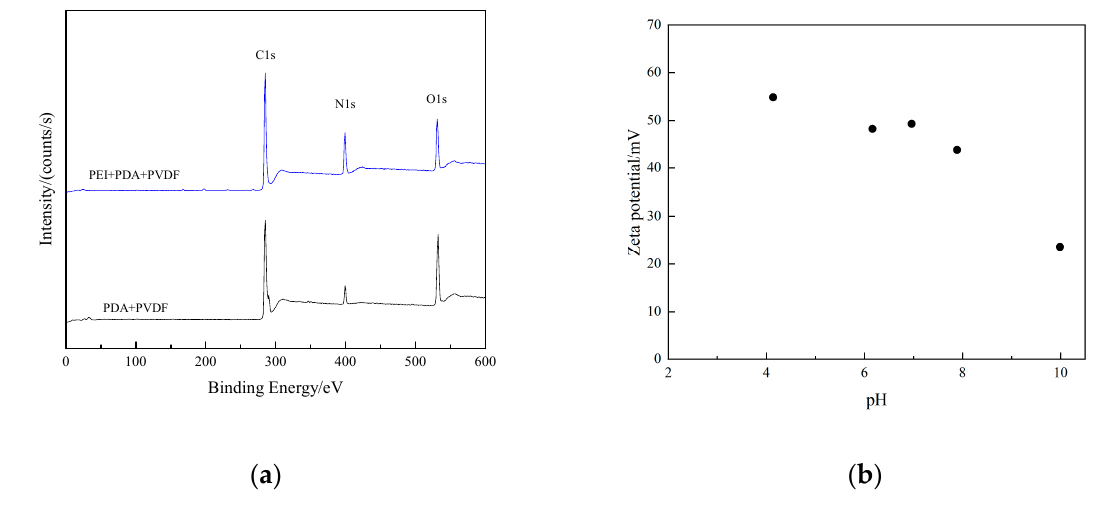
Figure 9. ( a ) XPS wide scans and ( b ) Zeta potential of MA. The test results of Zeta potential on the surface of PEI@PVDF-PDA are shown in Figure 9b. PEI@PVDF-PDA was positively charged in the solution with a pH value of